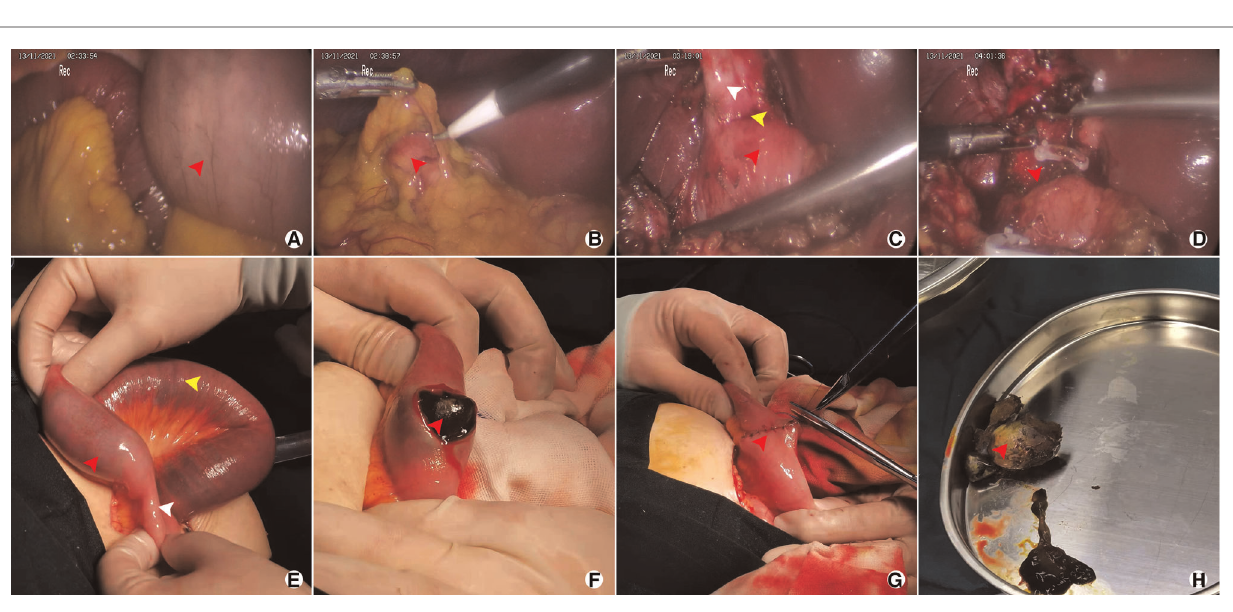
FIGURE 3 | Representative images afteroperation ofthe71-year-oldfemalepatient whowas diagnosed CDFwith GI; (A) Dilatation of smallbowel (red arrow); (B) Atrophic gallbladder covered by great omentum; (C) CDF from a laparoscopic view, including atrophic gallbladder (white arrow), ill-de fi ned borderline (yellow arrow), and duodenum (red arrow); (D) Partial cholecystectomy and fi stula (red arrow); (E) Impacted gallstone (red arrow), dilatation of small bowel (yellow arrow) and emptiness of distal intestinal (white arrow); (F) Enterolithotomy (longitudinal incision, red arrow); (G) Closure of the intestinal (red arrow); (H) gallstone extracted from small bowel (red